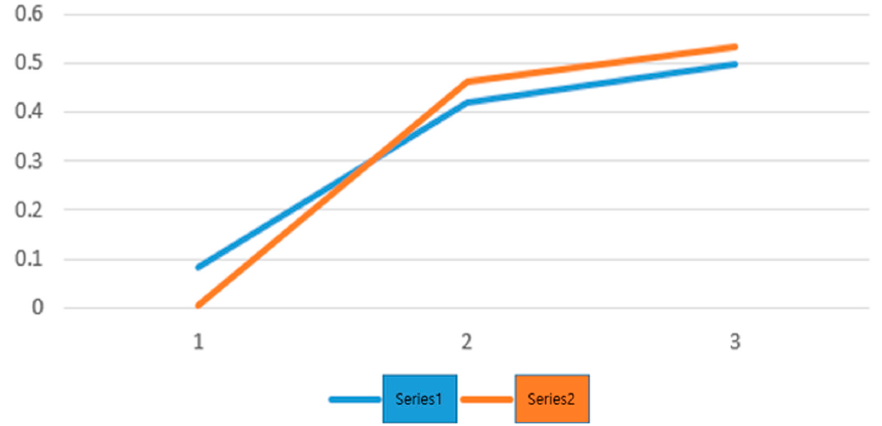
Figure 21. Comparison between the appearance frequency of “intense heat” and maximum power. (“Living Culture” section of Naver news, 2018).